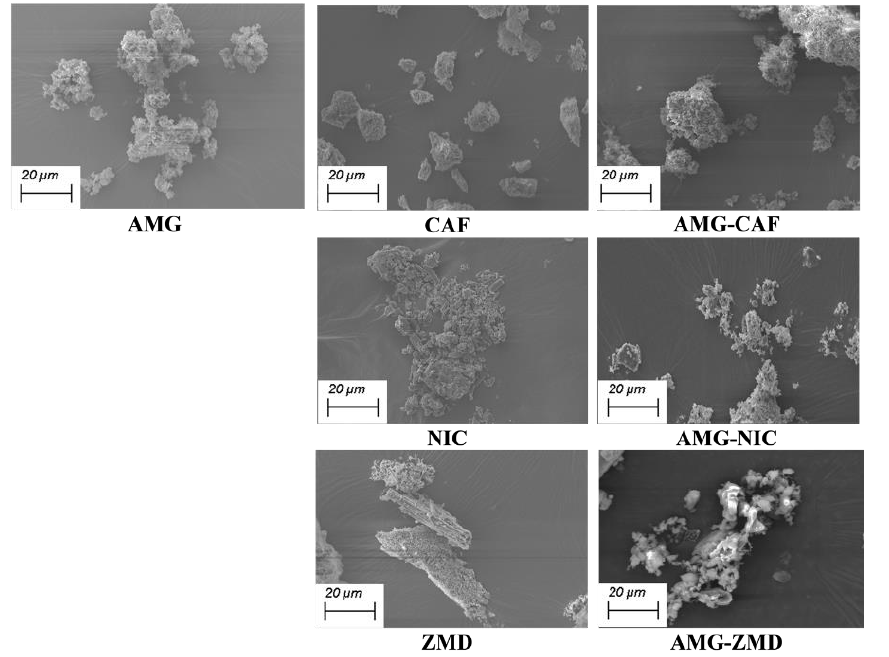
Figure 5. Comparison of micrographs of pure AMG and conformers after LAG treatment with their respective eutectic mixtures at 1.0 Kx magnification.